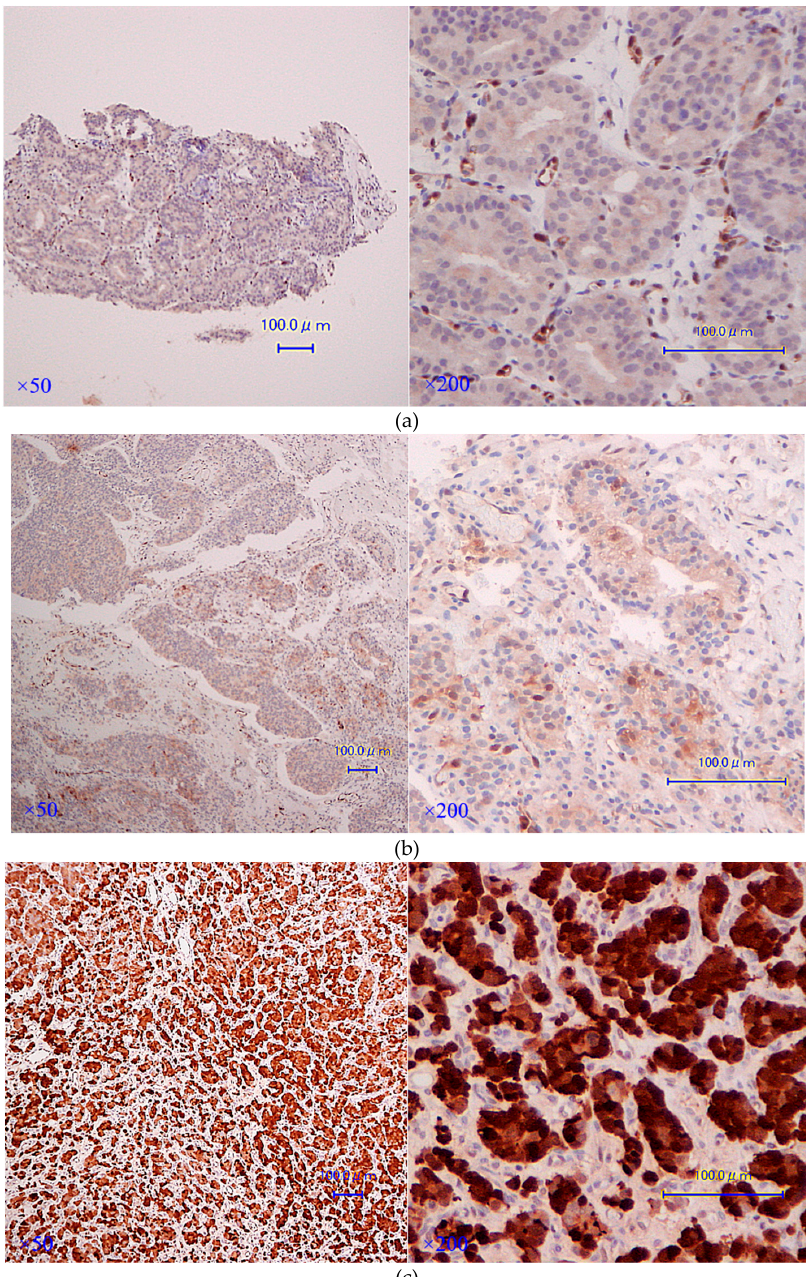
Figure 4. ( a – c ) AKR1C3 immunostaining of HNPC, Hormone-sensitive prostate cancer (HSPC), and CRPC specimens in the same case (case 9). CAB (leuprolide acetate + bicalutamide) was initiated for case 9 after diagnosis (Figure 3a): ( a ) HNPC (biopsy) specimens at diagnosis, PSA: 29.9 ng / mL (normal reference range 0-4.0 ng / mL), AKR1C3: Proportion score (PS), 1; Intensity score (IS), 1; Total score (TS), 2; ( b ) HSPC specimens on day 45 after commencing CAB, PSA: 2.89 ng / mL, AKR1C3: PS, 2; IS, 2; TS, 4; ( c ) CRPC specimens, PSA: 46.74 ng / mL, AKR1C3: PS, 4; IS, 3; TS 7. After CAB initiation, transurethral lithotomy (TUL) and TUR-P were performed due to repeated urinary retention resulting from bladder stone (Figure 4b). After 1.5 years of bicalutamide, 2 months of flutamide, and 3 months of ethinylestradiol, together with continuous luteinizing hormone-releasing hormone (LHRH) local tumor (Figure 4c). The immunostaining results suggested increased expression of AKR1C3 in PCa tissues with disease